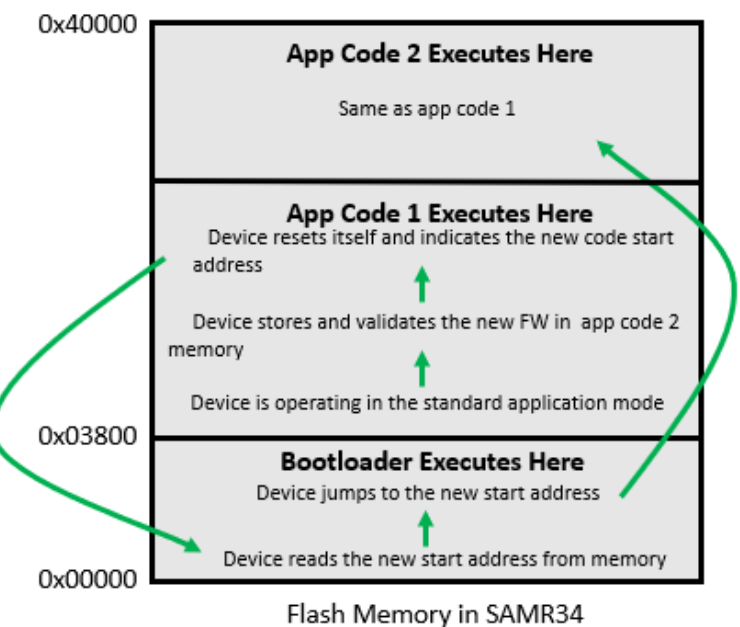
Figure 6. Flash memory breakdown for using internal